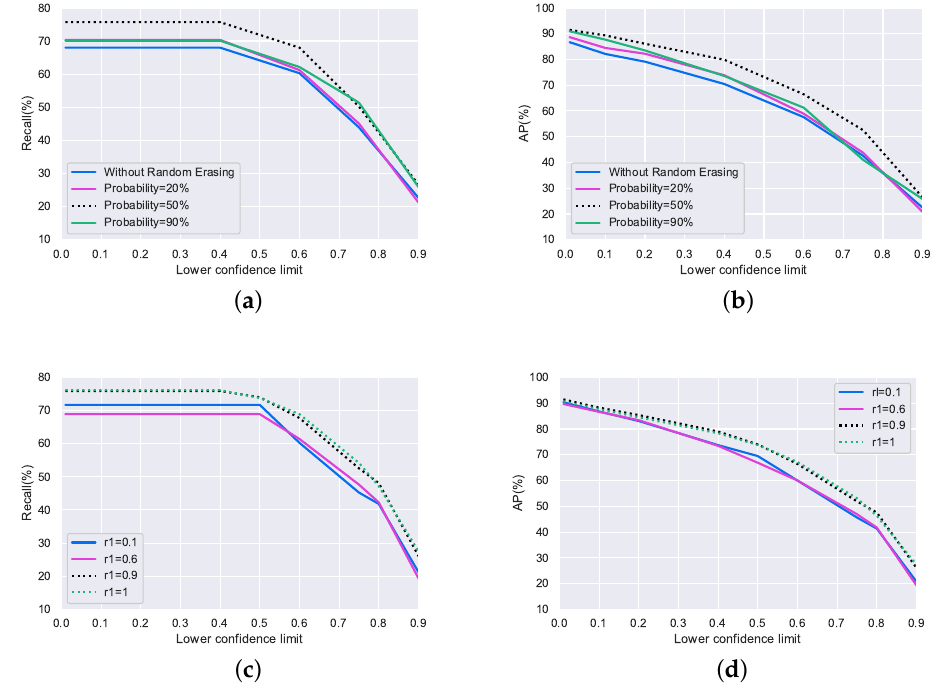
Figure 10. ( a , b ) Recall and AP of the model under different Random Erasing enabled probabilities; ( c , d ) Recall and AP of model under different Random Erasing aspect ratio